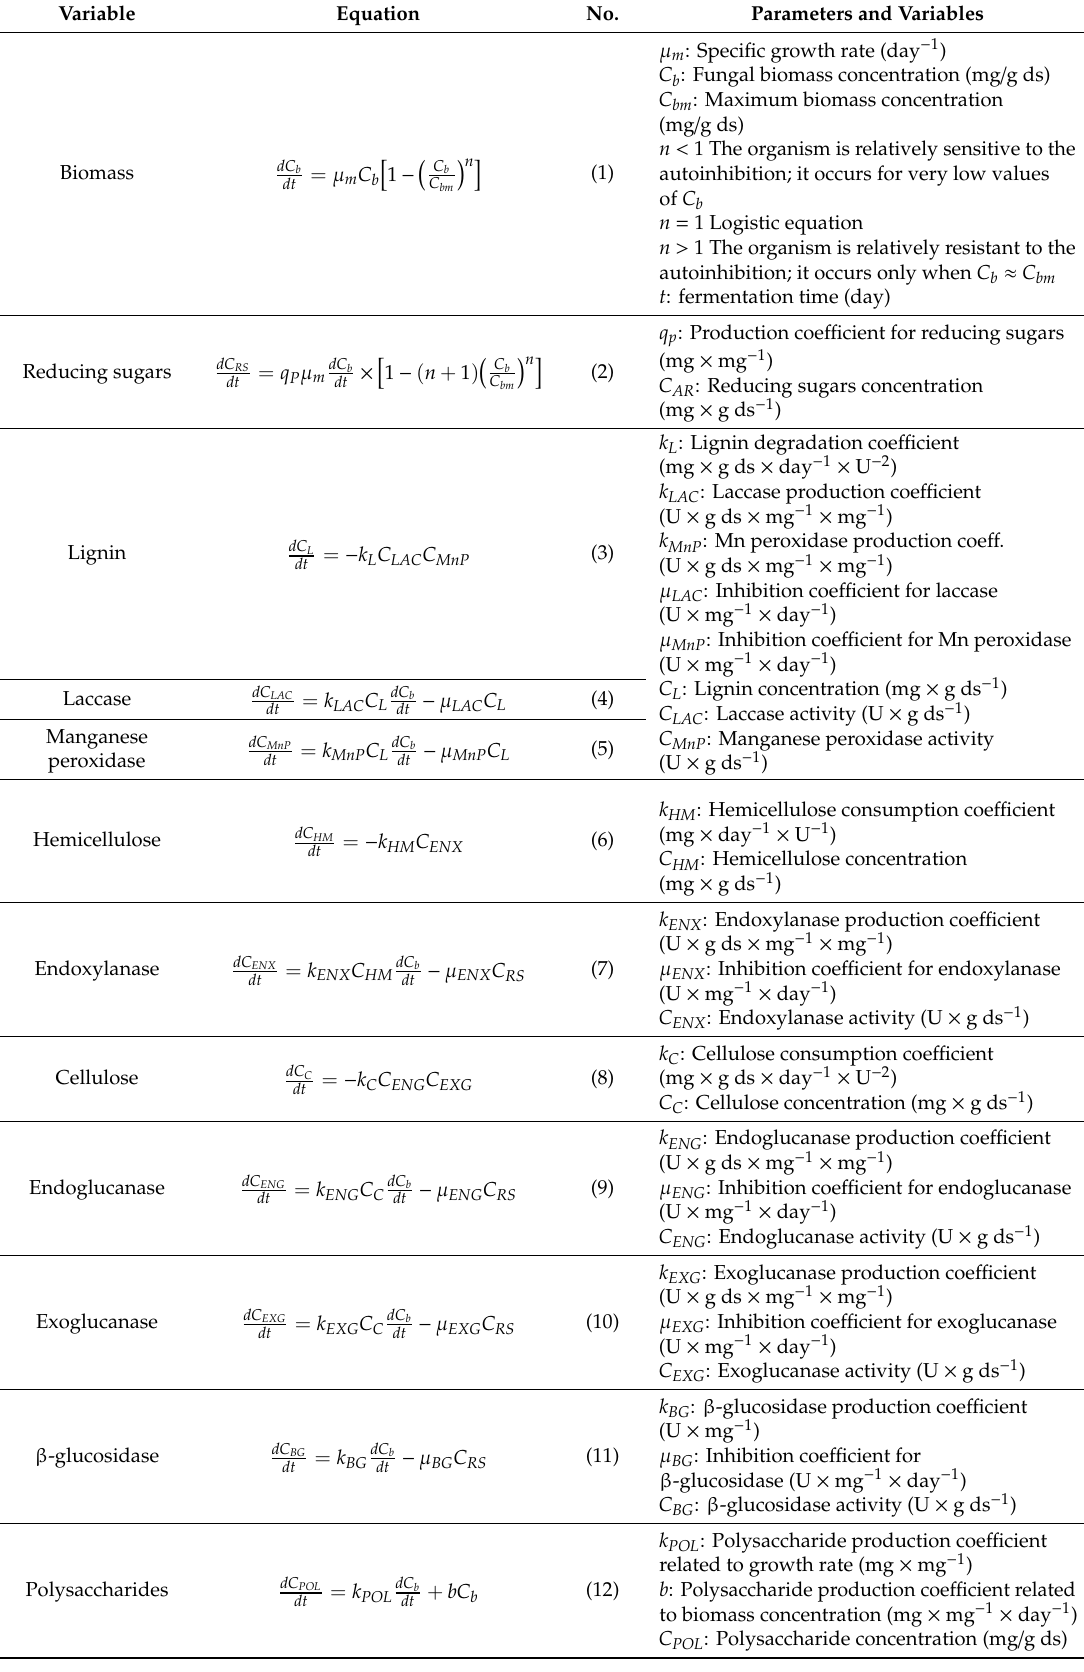
Table 3. Mathematical model describing the production of biomass and polysaccharides, and consumption of the components of the lignocellulosic